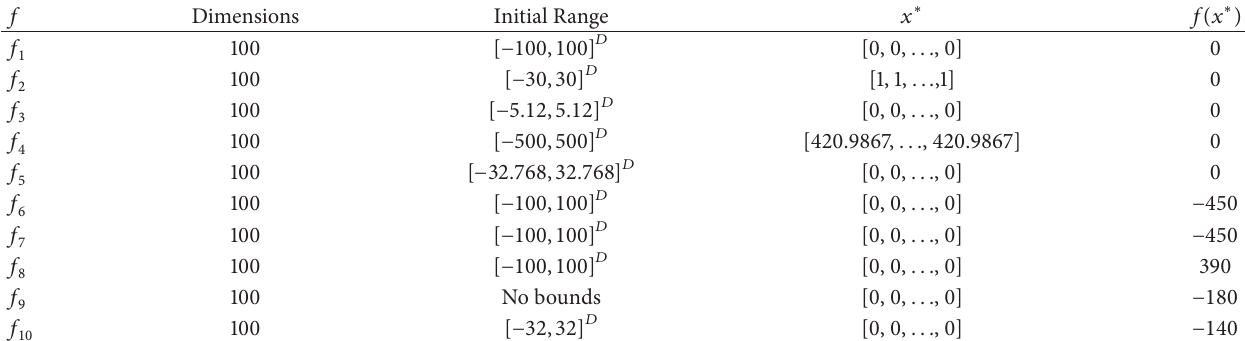
Table 9: Parameters of the test